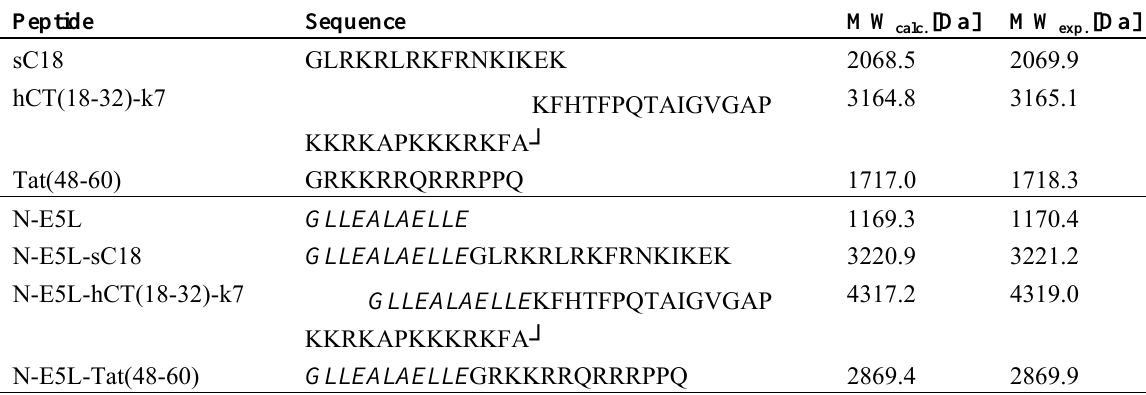
Table 1. Names, sequences and molecular weights of the investigated